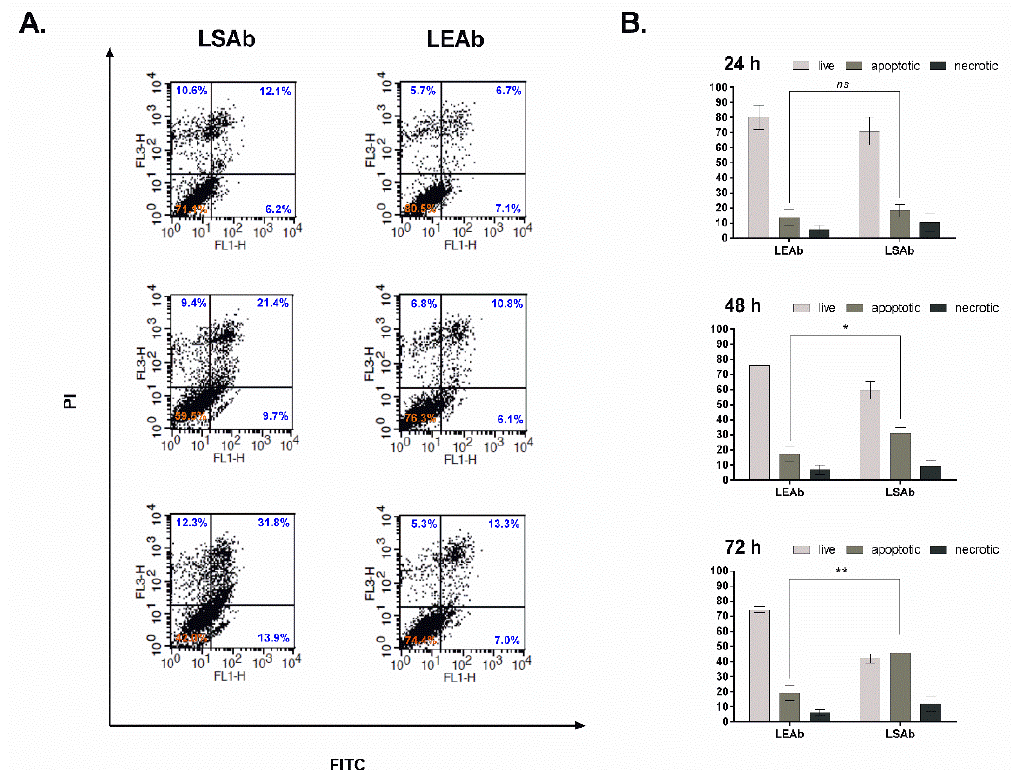
Figure 7 . Determination of apoptosis/necrosis level after 24, 48 and 72 h of incubation with immunoliposomal form of simvastatin or control empty immunoliposomes (6.5 µM of